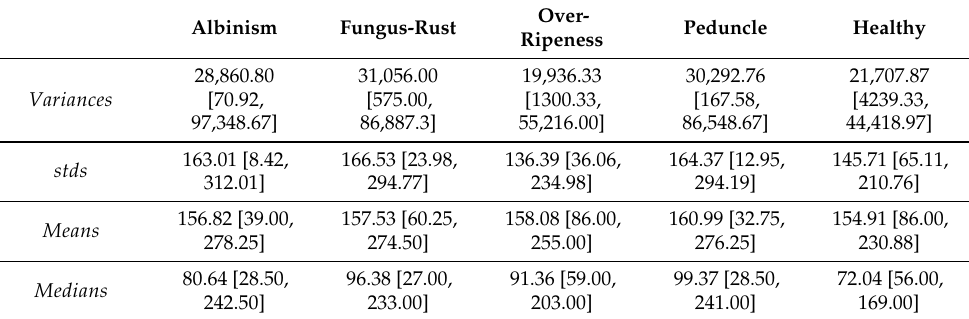
Table 2. Analysis using descriptive statistics. The table shows the average thresholds and the learning bounds of each